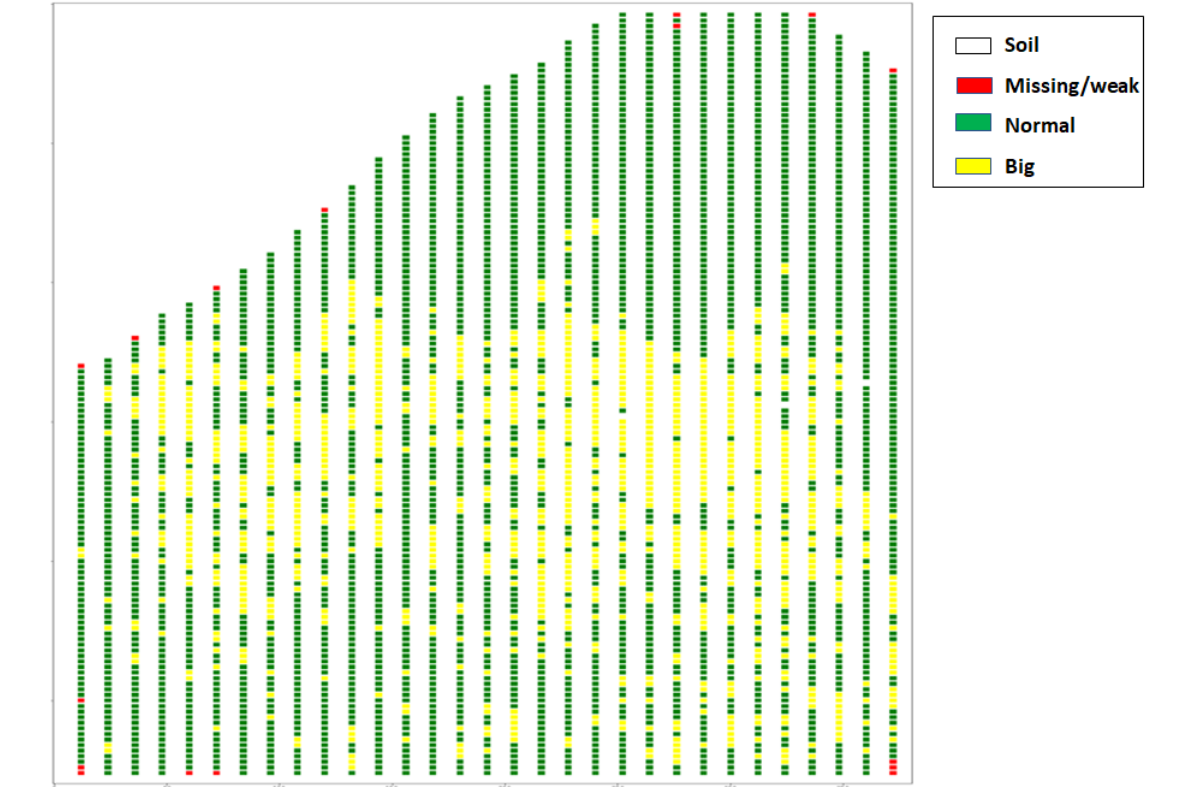
Figure 9. Tree classification by size in the parcel.